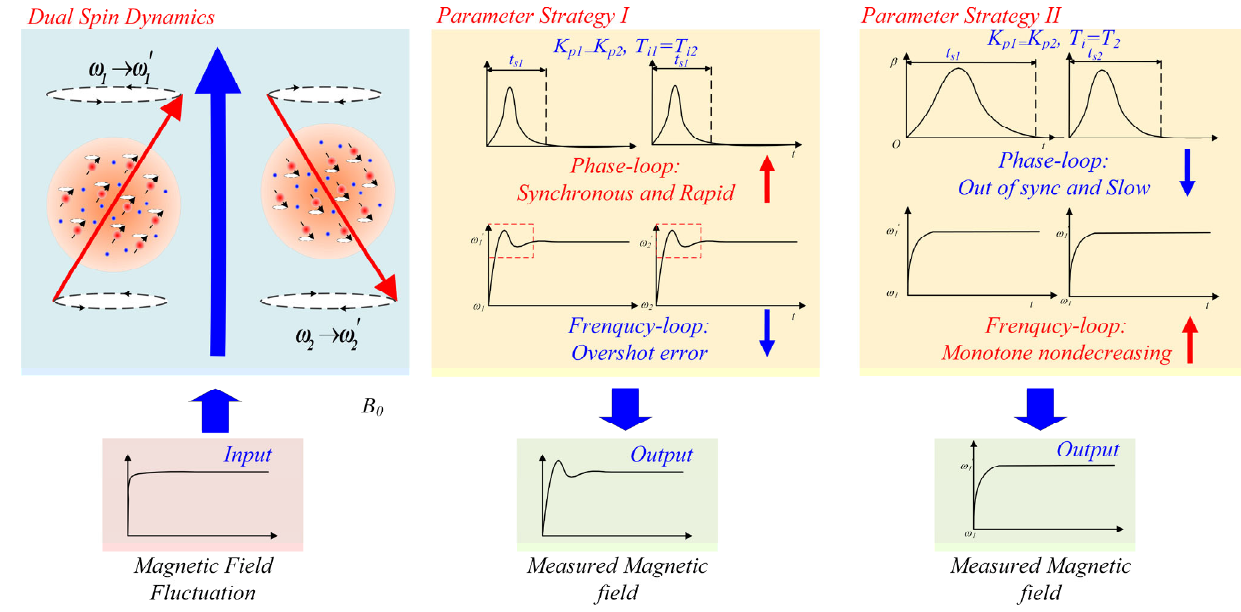
Figure 3. Analysis of transient errors of the magnetic ‐ field measurement .